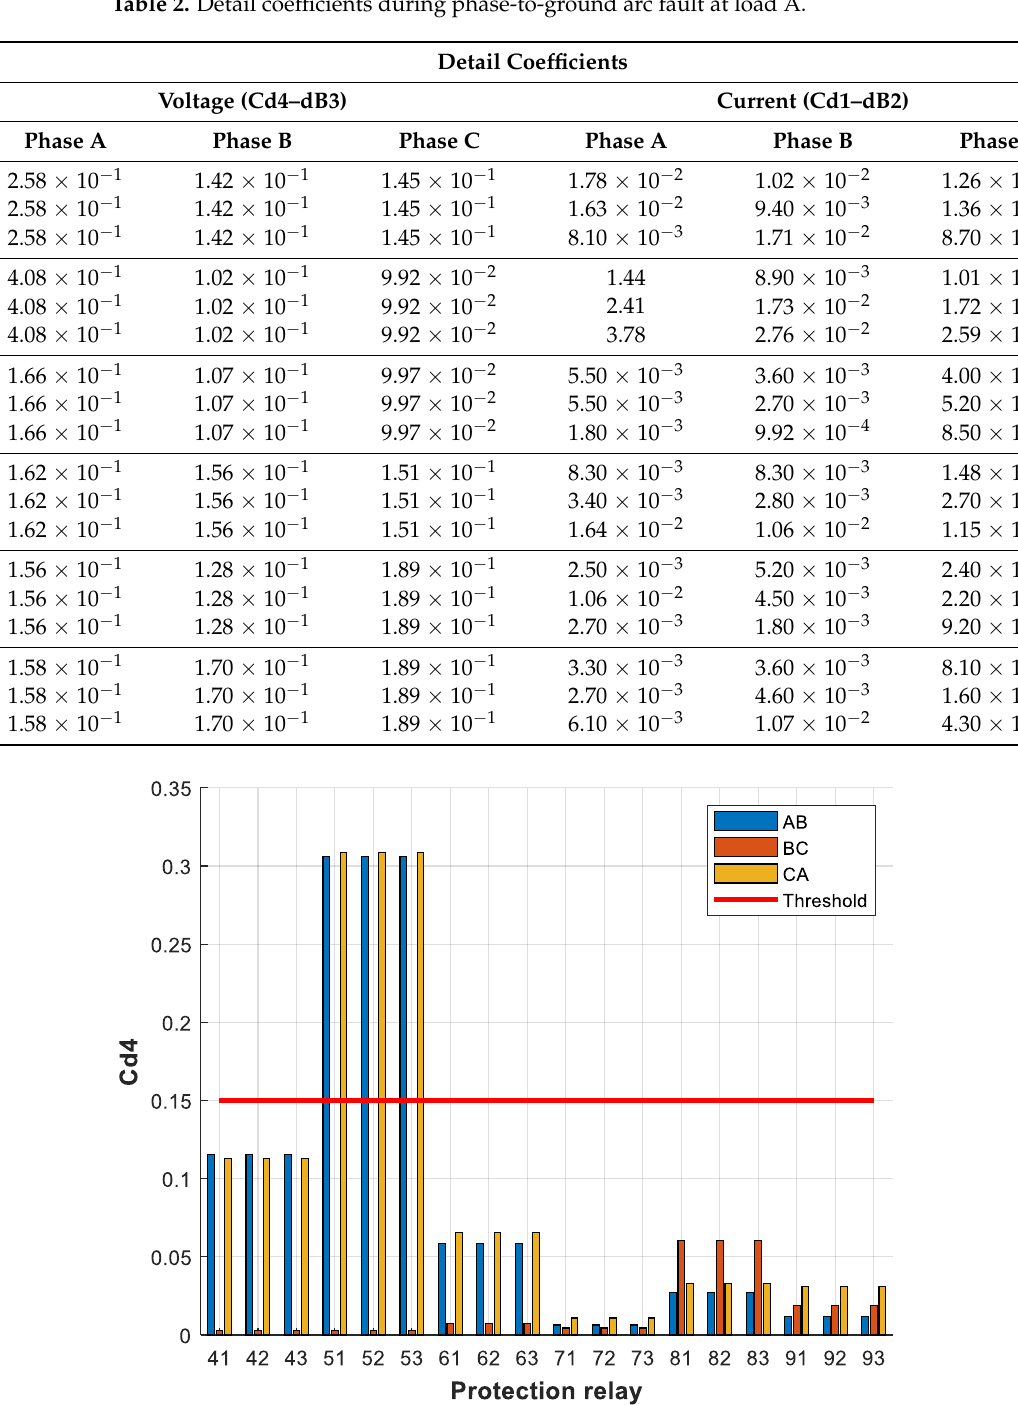
Figure 8. Differences in the current detail Cd1-dB2 at load A. In Figures 7 and 8, relays 51, 52 and 53 exceeded the thresholds established in the protection algorithm. Only relay 53 was tripped, as it had the largest difference between